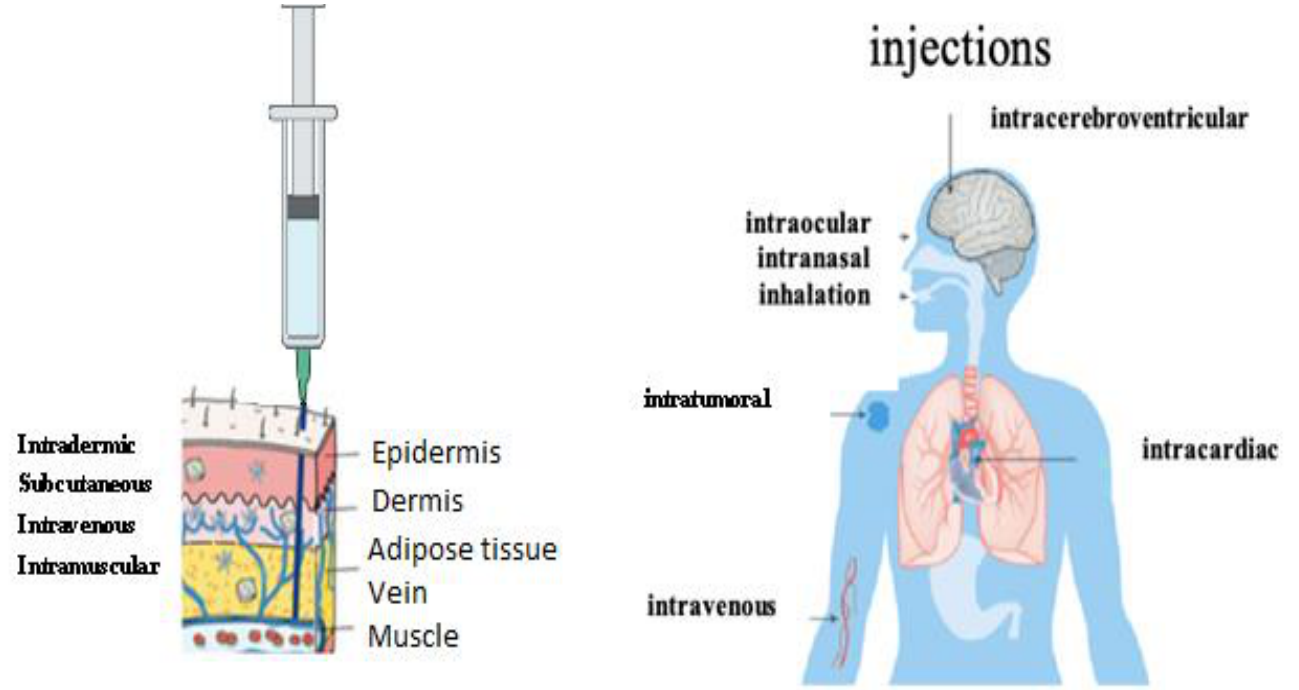
Figure 10. administration routes of LNP-ARNm [126]. Figure 10. Administration routes of LNP-ARNm